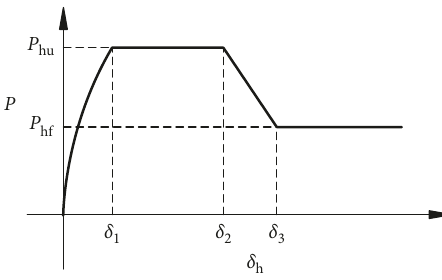
Figure 11: Hook force-hook deformation relationship.